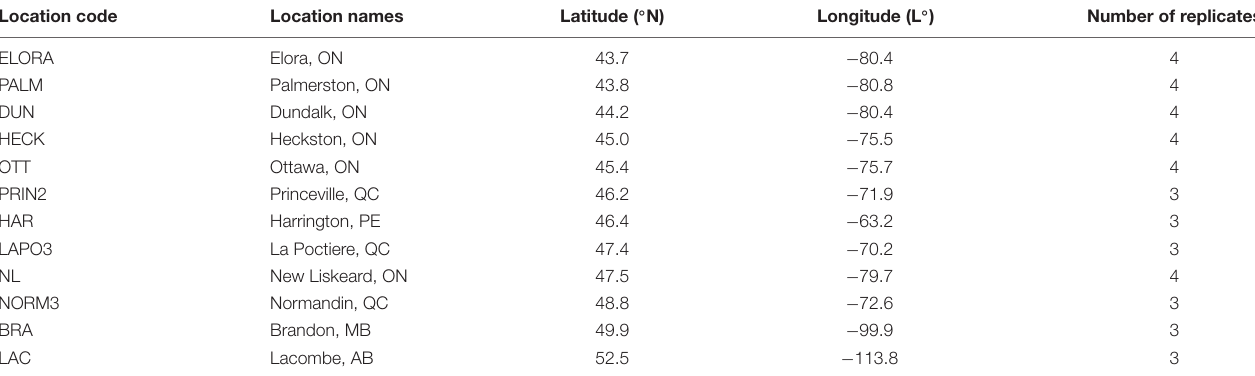
TABLE 1 | Test locations involved in the 2015–2019 oat registration test and their geographical coordinates (sorted by latitude). Location code